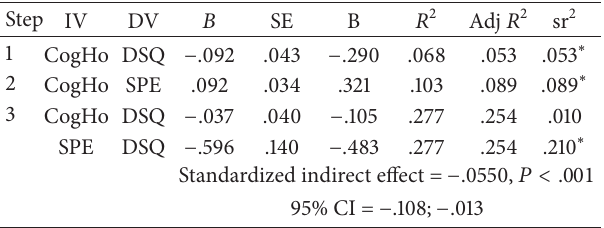
Table 2: Cognitive hostility and daily SQ mediated by stress per event.